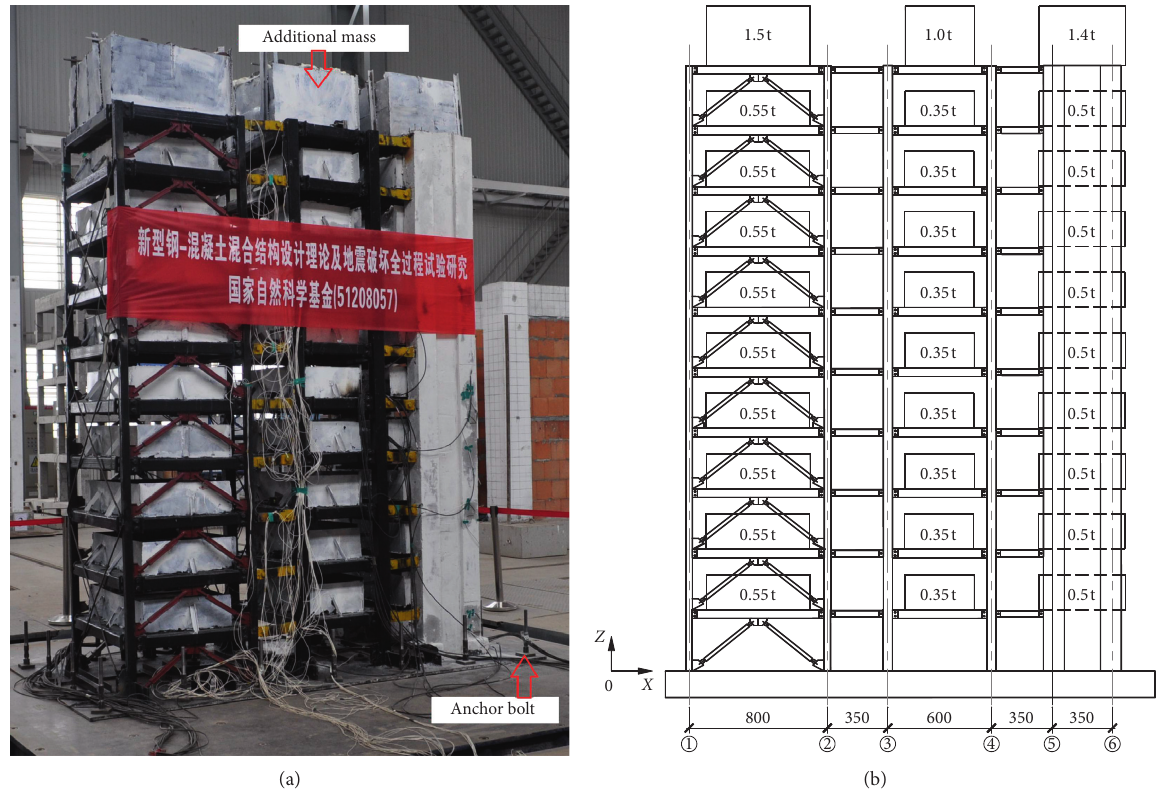
Figure 12: Specimen with additional masses. (a) Picture. (b)